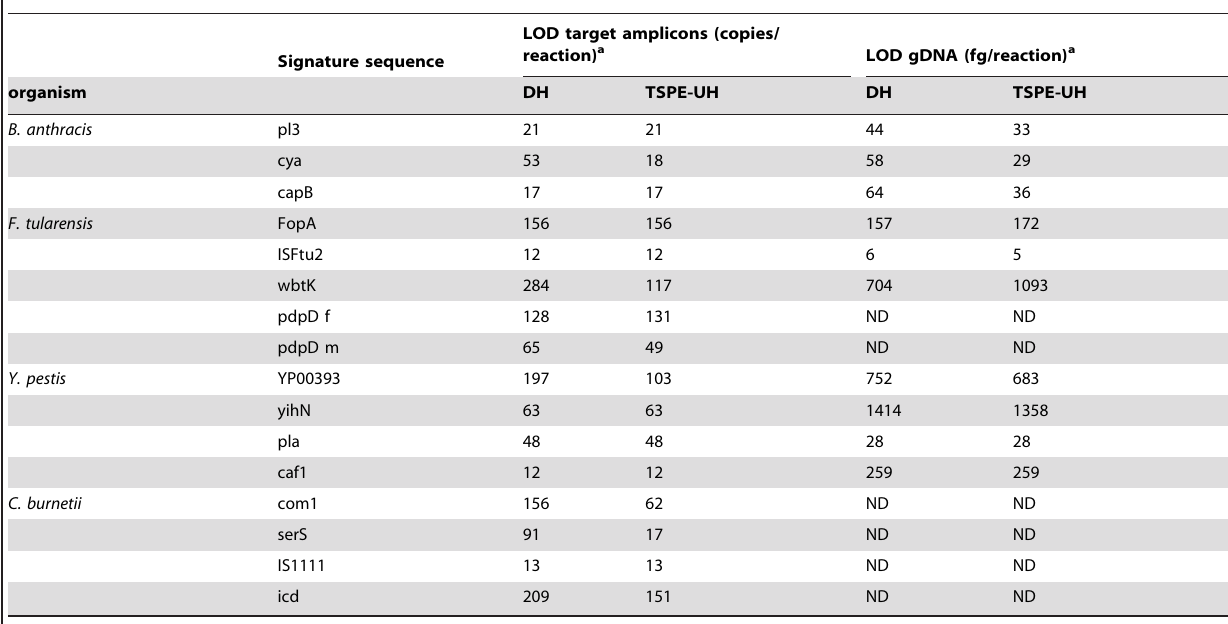
Table 2. Detection limits of the DH and TSPE-UH suspension array formats.